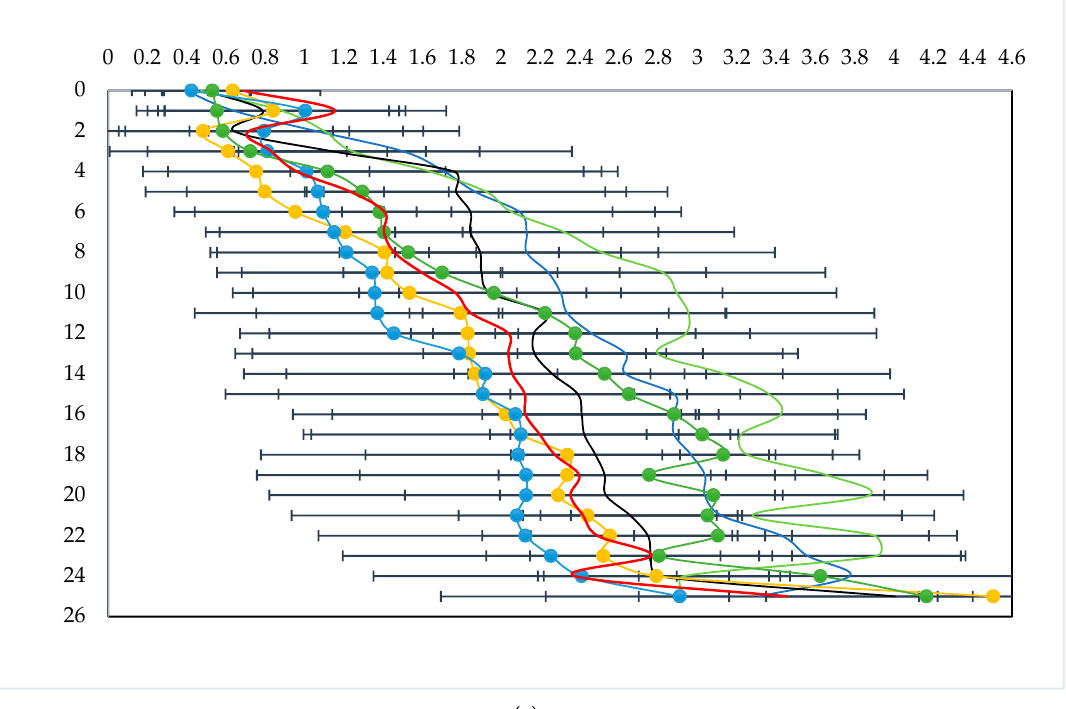
Figure 3. Impact of multi-cropping on soil penetration resistance, 2020. ( a ) Beginning of the vegetative season; ( b ) middle of the vegetative season; and ( c ) end of the vegetative season. MA: maize, HE: hemp and FB: faba bean mono-crops; MA + HE: maize + hemp, MA + FB: maize + faba bean, and HE + FB: hemp + faba bean binary-crops; MA + HE + FB: maize + hemp + faba bean ternary-crops. Bars mean standard